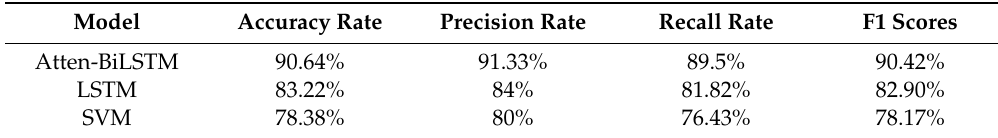
Table 4. The recognition performance of di ff erent models.